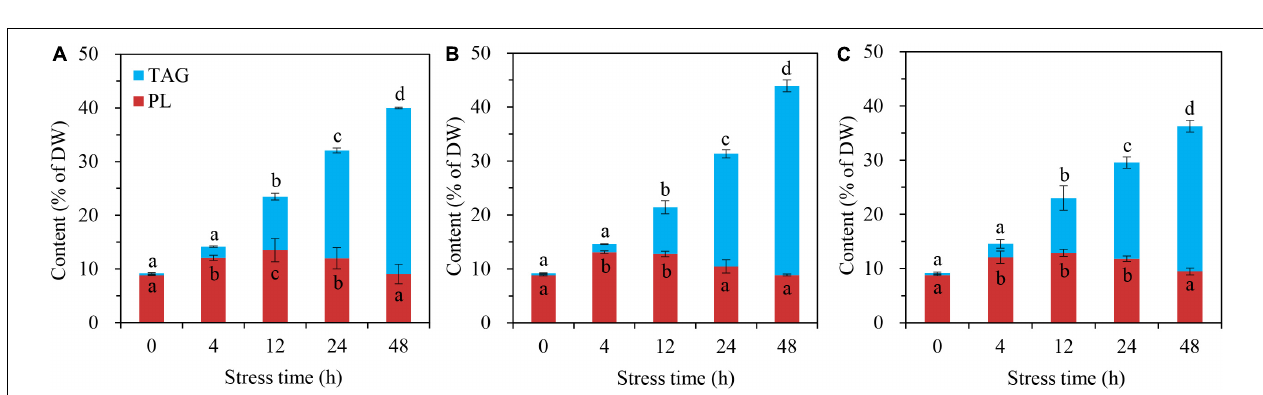
FIGURE 4 | Time course of changes in contents of the total polar lipids and TAG in C. reinhardtii BAFJ5 under three carbon supply regimes over 48 h of HL-N. Panels (A–C) indicate mixotrophic 1 (17 mM acetate and 2% CO 2 , v/v), mixotrophic 2 (17 mM acetate and ambient 0.04% CO 2 , v/v), and autotrophic (2% CO 2 , v/v) conditions, respectively. PL indicates polar lipids, including monogalactosyldiacylglycerol (MGDG), digalactosyldiacylglycerol (DGDG), sulphoquinovosyldiacylglycerol (SQDG), diacylglycerol- N , N , N -trimethylhomoserine (DGTS), phosphatidylethanolamine (PE), phosphatidylglycerol (PG), and phosphatidylinositol (PI). Values are the means of three independent replicates ( n = 3). The distinct letters labeled for the same parameter indicate the statistically significant difference by Tukey’s honestly significant difference (HSD) test. DW, cellular dry weight.